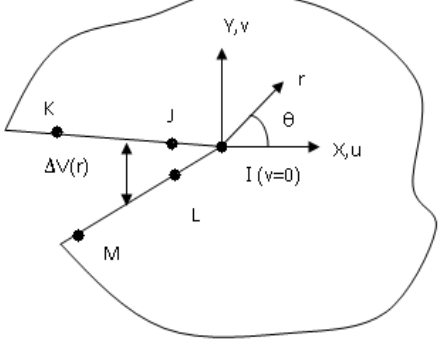
Figure 4: Representation of displacements to be used in analysis.